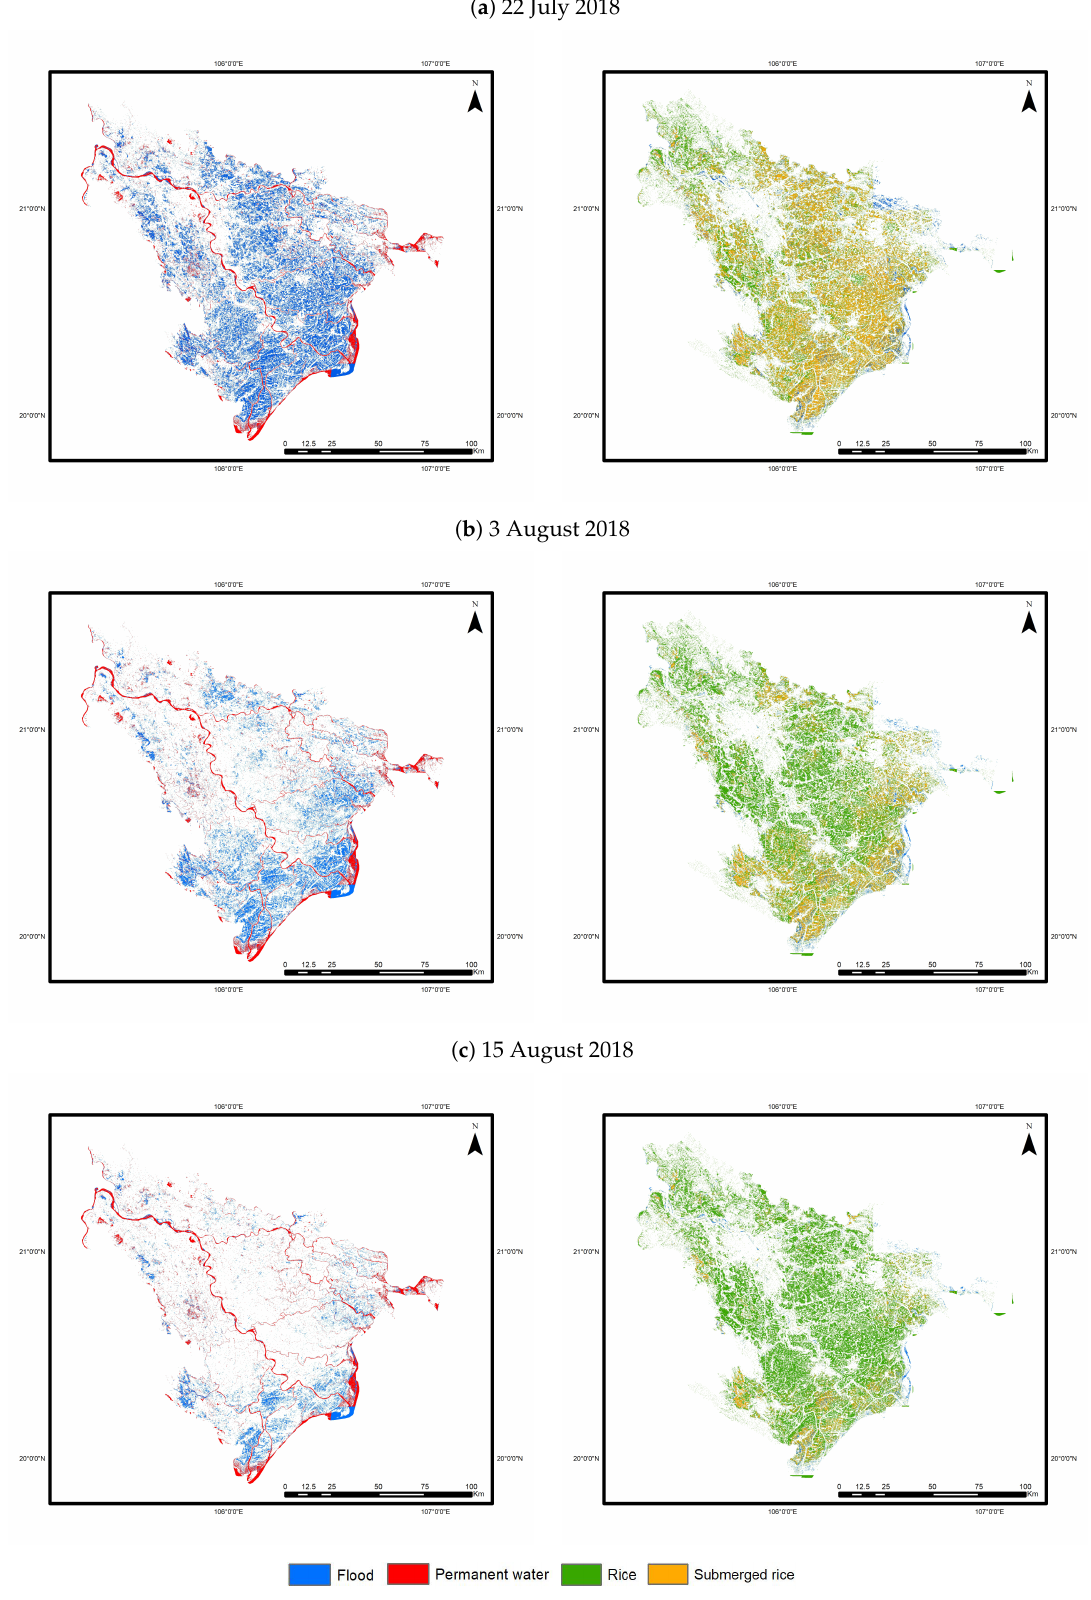
Figure 10. Visualization of flood map with permanent water map ( left column ) and rice map with submerged rice map ( right column ) on 22 July 2018, 3 August 2018 and 15 August 2018, for 10 provinces in the